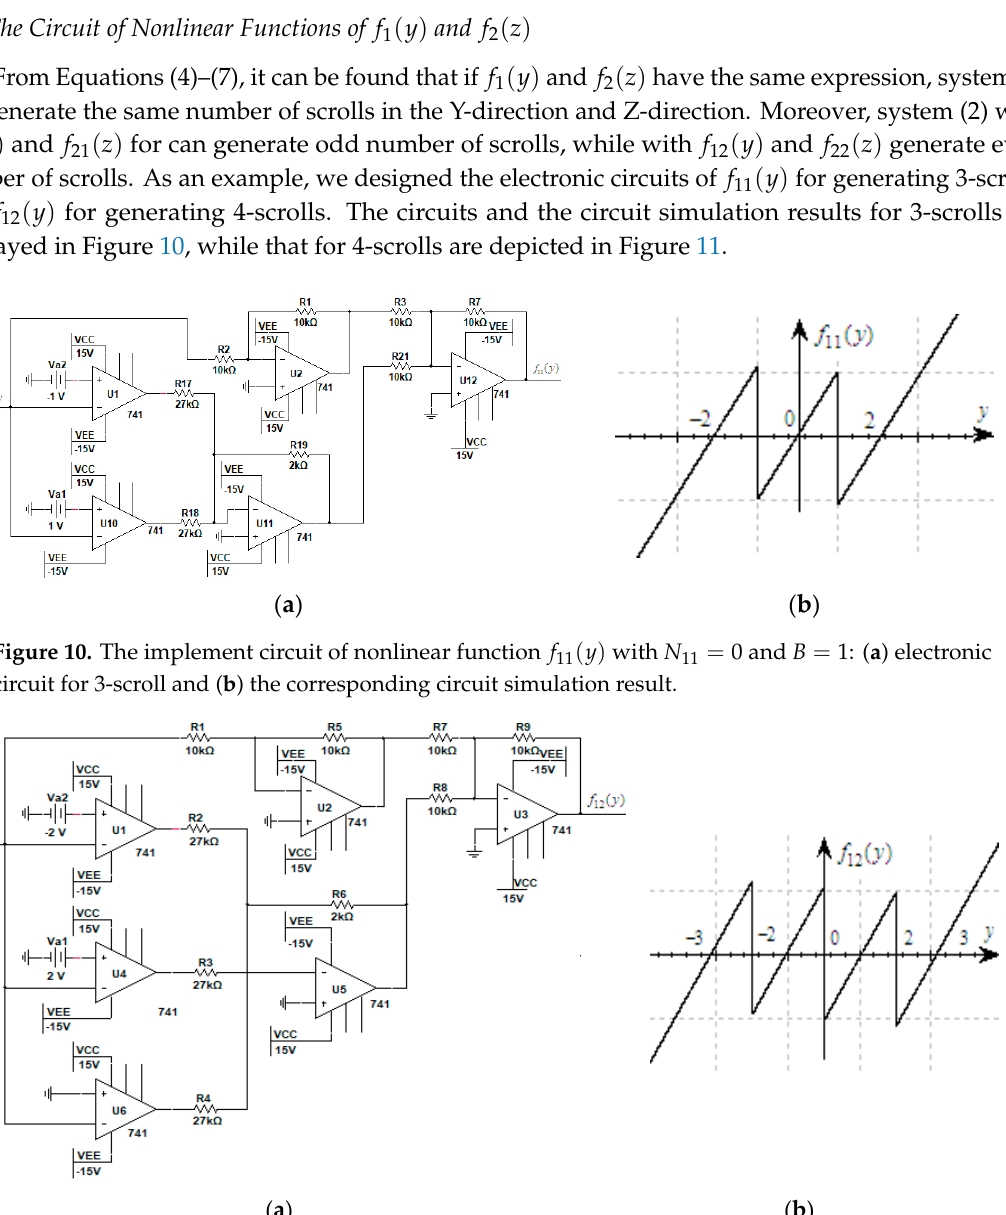
( ) f y with 1 N = and 1 B = : ( a ) 12 12